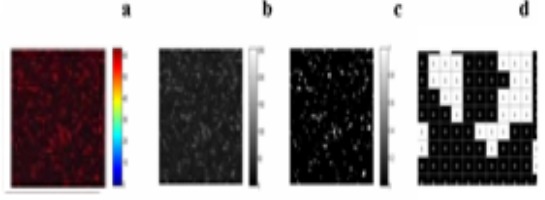
Fig.5 (a) : Apart of speckle pattern in RGB image obtained by using a CCD camera from a surface with R 0.94 μ m, (b): Converting the image (a) to gray image, (c):Convert the image (b) to binary image, (d): is zoom in the image (c) to show the pixel